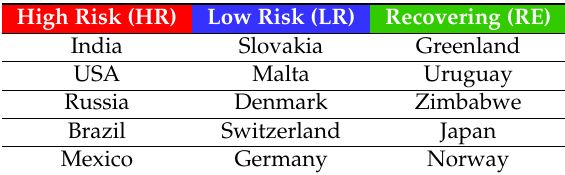
Table 4. Examples of some high risk, low risk, and recovering countries based on upcoming 25 days prediction (August 2020). High Risk